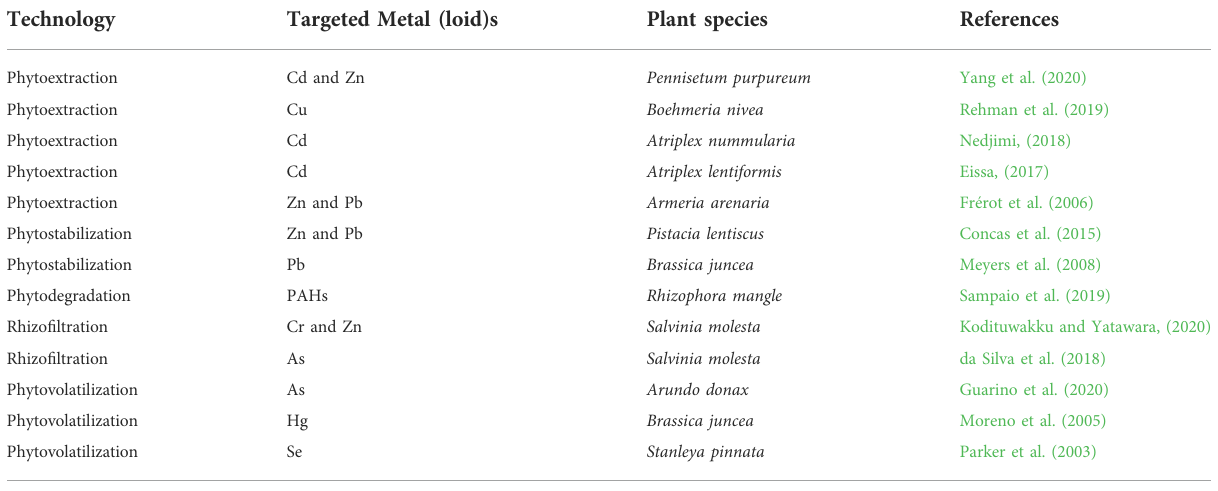
TABLE 7 Phytoremediation Technologies along with speci fi c plants and targeted metal(loid)s.